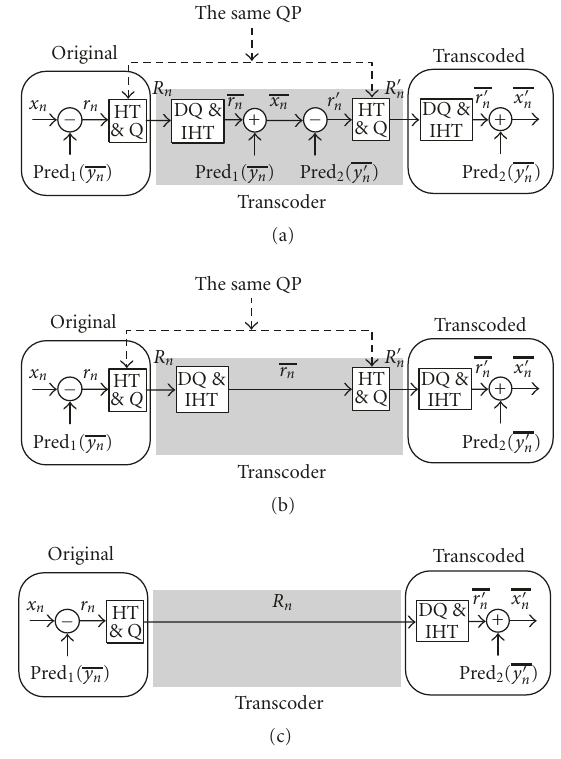
Figure 1: Illustration of a novel transcoder: (a) the simplified transcoding process, (b) the simplified transcoder when the predic- tion blocks are the same, (c) the fast transcoder that can bypass the input transform coe ffi cients.